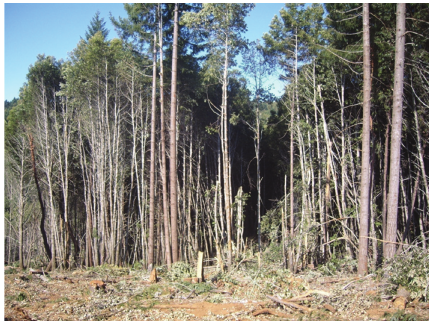
Figure 1: Tanoak dominated stand that was once a productive conifer stand, now managed through rehabilitation